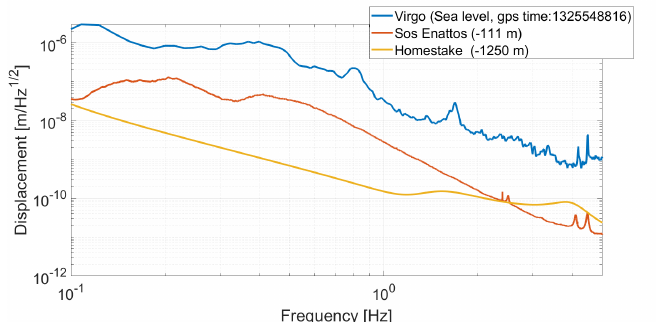
Figure 4. This plot shows the spectral density of the seismic noise displacement measured at the Sos-Enattos mine, compared to those measured near the Central building of Virgo (Pisa, Italy) and at the former mine of Homestake (Lead, SD -USA). The Homestake seismic profile was reconstructed using the data shown in the bottom right of Figure 6.10 in [14].